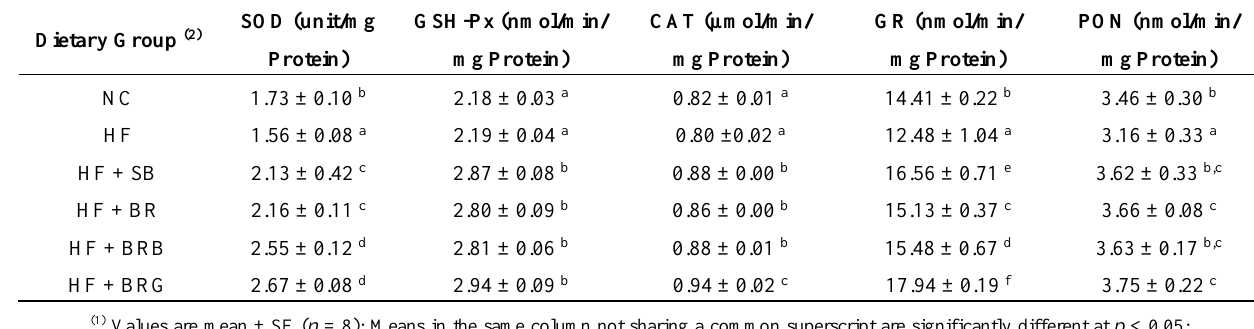
Table 7. Hepatic antioxidant enzyme activity (1) in mice fed with high fat diet supplemented with rice fermented